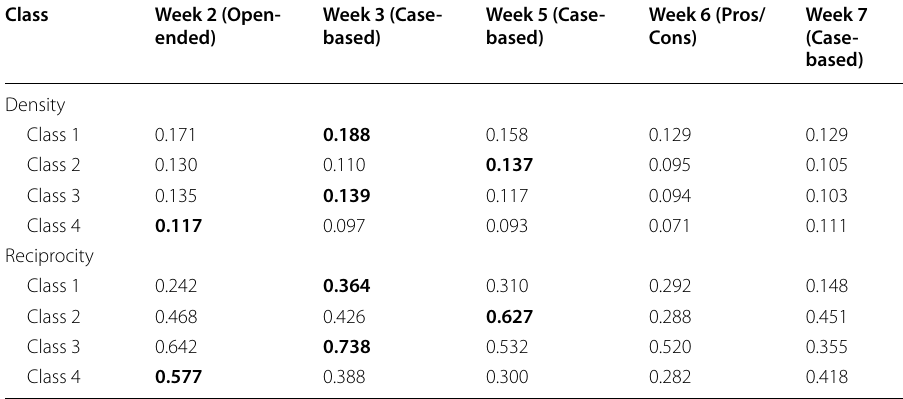
Table 3 Changes in density and reciprocity on weekly discussion boards